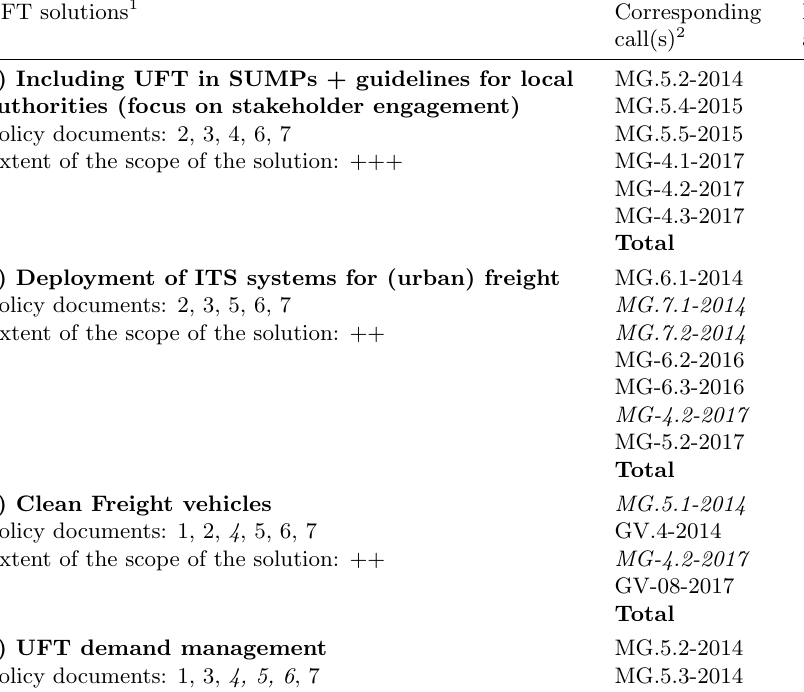
Table 6: Comparison between UFT solutions and corresponding call(s) UFT solutions 1 Corresponding Budget call(s) 2 available